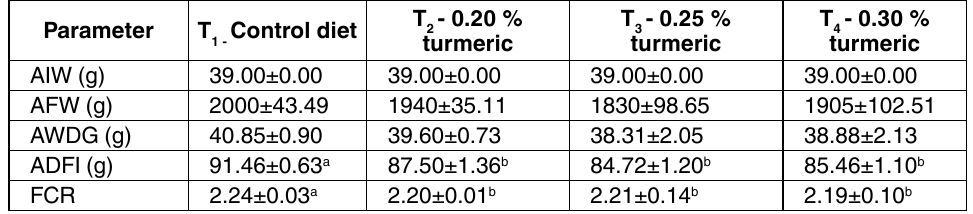
Table 2. Effect of turmeric powder on growth performance of finisher broiler chickens